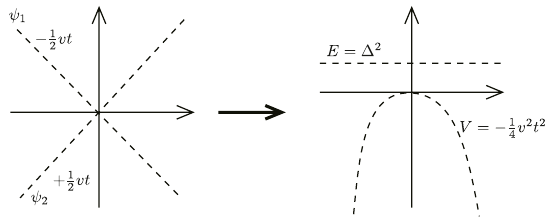
Figure 11 . Left: state crossing in the Landau-Zener model. Right: after decoupling the equa- tions, the state crossing of the Landau-Zener model corresponds to the scattering problem of the Schrödinger